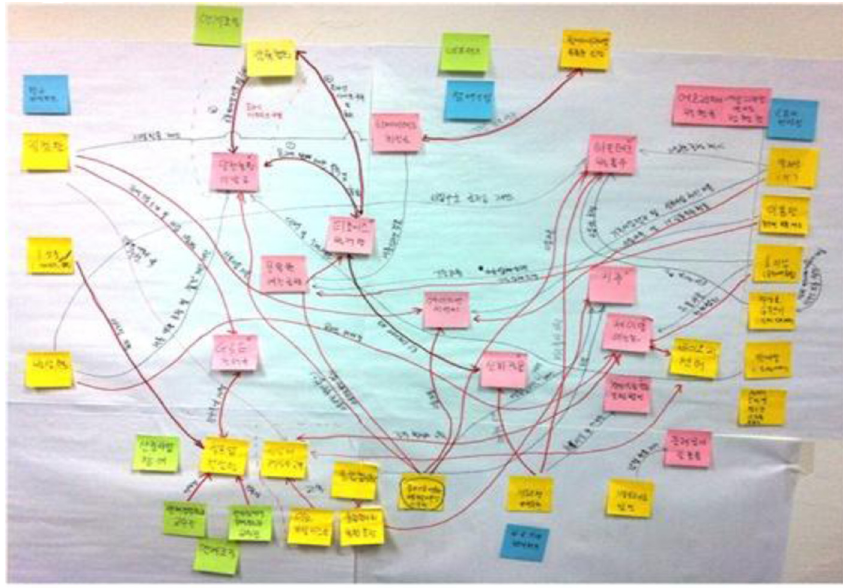
Figure 2. Diagram of relationships between participants in the BCD of G